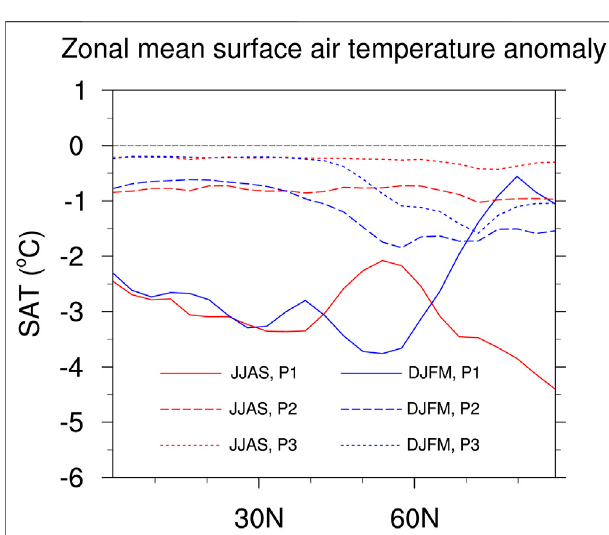
FIGURE 4 | Zonal mean SAT anomalies in summer (JJAS, red lines) and winter(DJFM,bluelines)overNHduringPeriod-1(solidline),Period-2(dashed line), and Period-3 (dotted